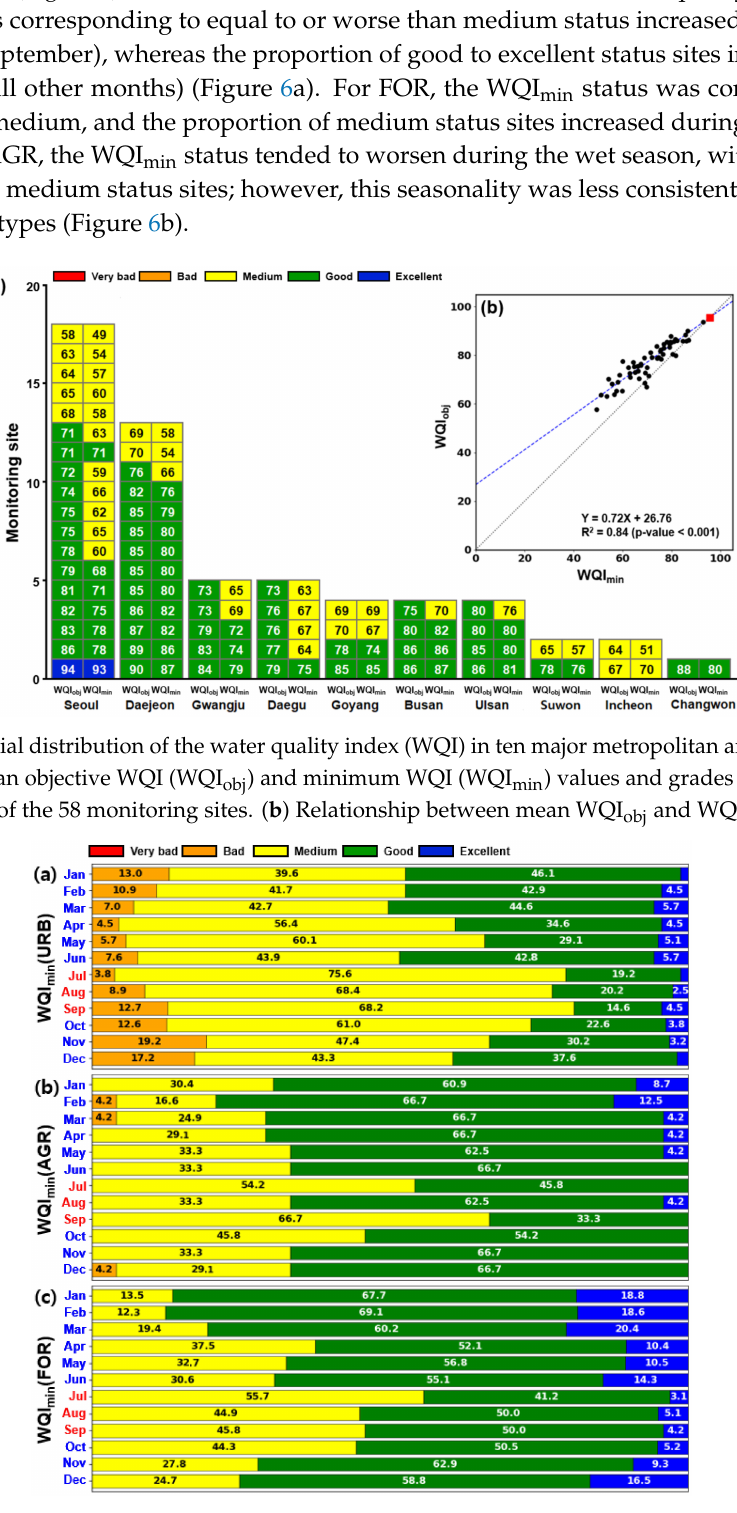
Figure 6. Monthly distribution (%) of minimum water quality index (WQI min ) grades from 2015 to 2018 for watersheds with, ( a ) urban-dominated, ( b ) agriculture-dominated, and ( c ) forest-dominated land-cover. Month names for dry and wet seasons are colored blue and red,